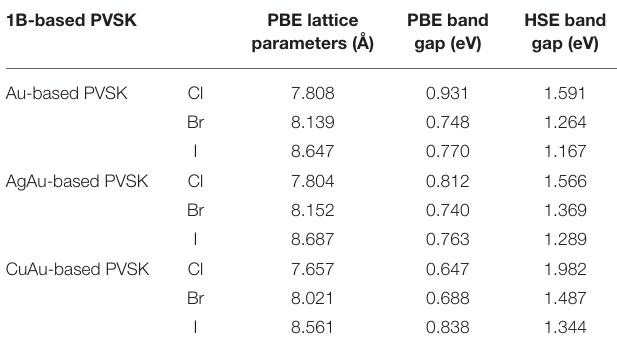
TABLE 1 | The structural parameters (Å), PBE band gap (eV), and HSE band gap (eV) of 1B-based perovskite solar cell